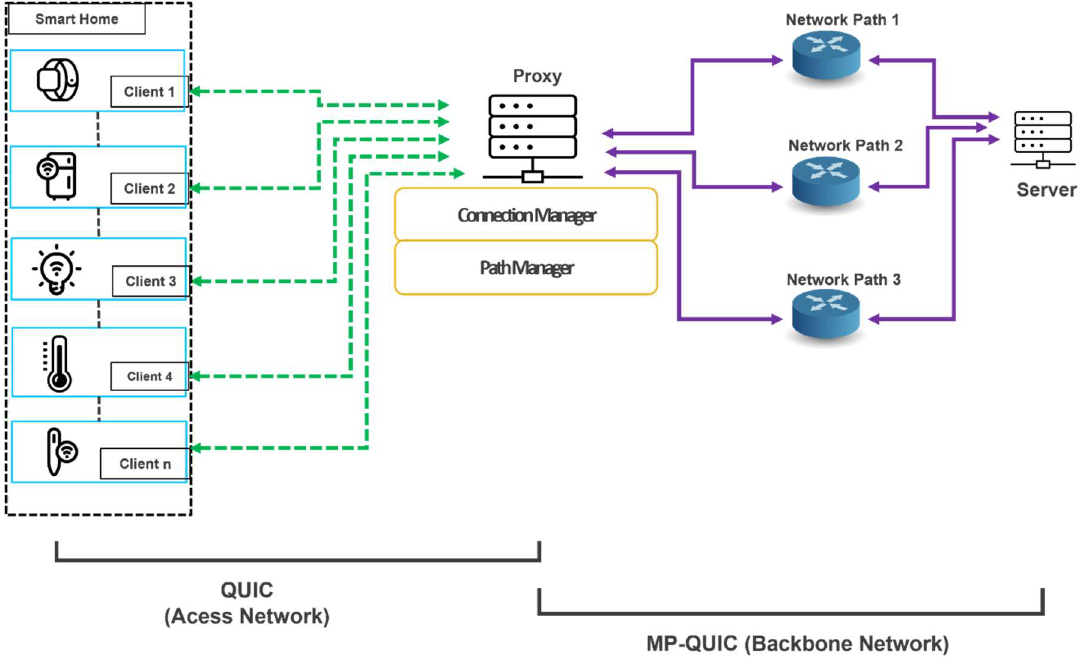
Figure 1. Proxy-based MP-QUIC transmission in IoT environment.